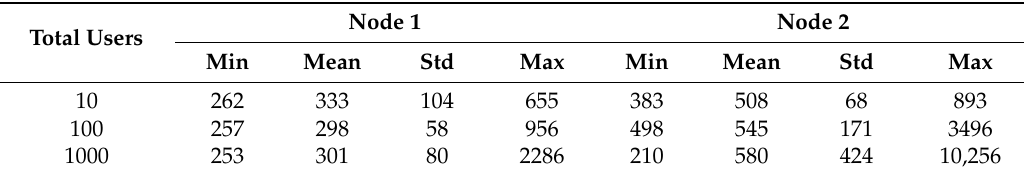
Table 1. Response